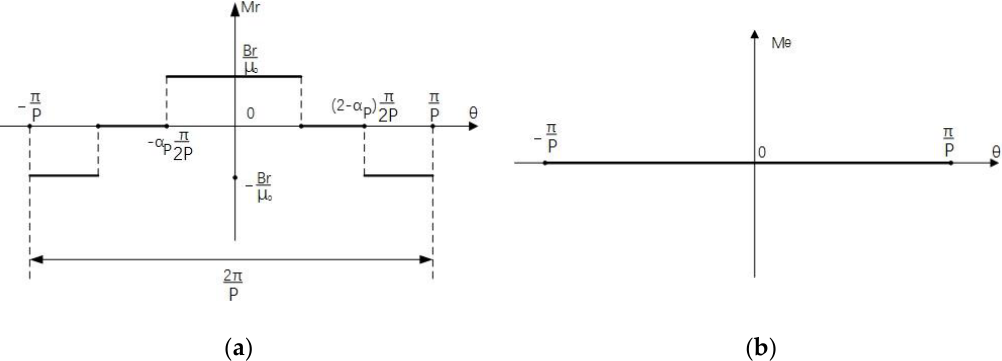
Figure 3. The main pole of the Halbach array.